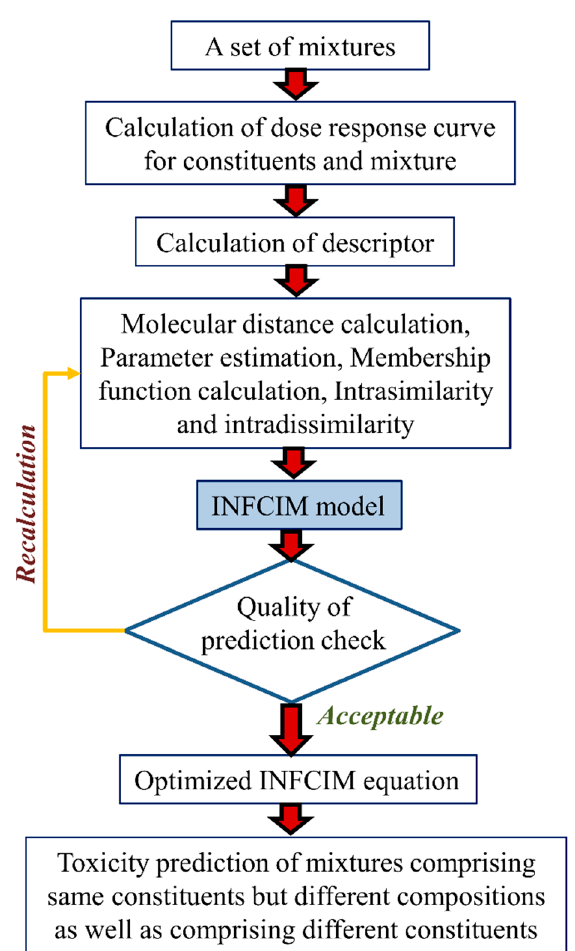
Figure 6. Strategy behind the integrated fuzzy concentration addition-independent action model (INFCIM).